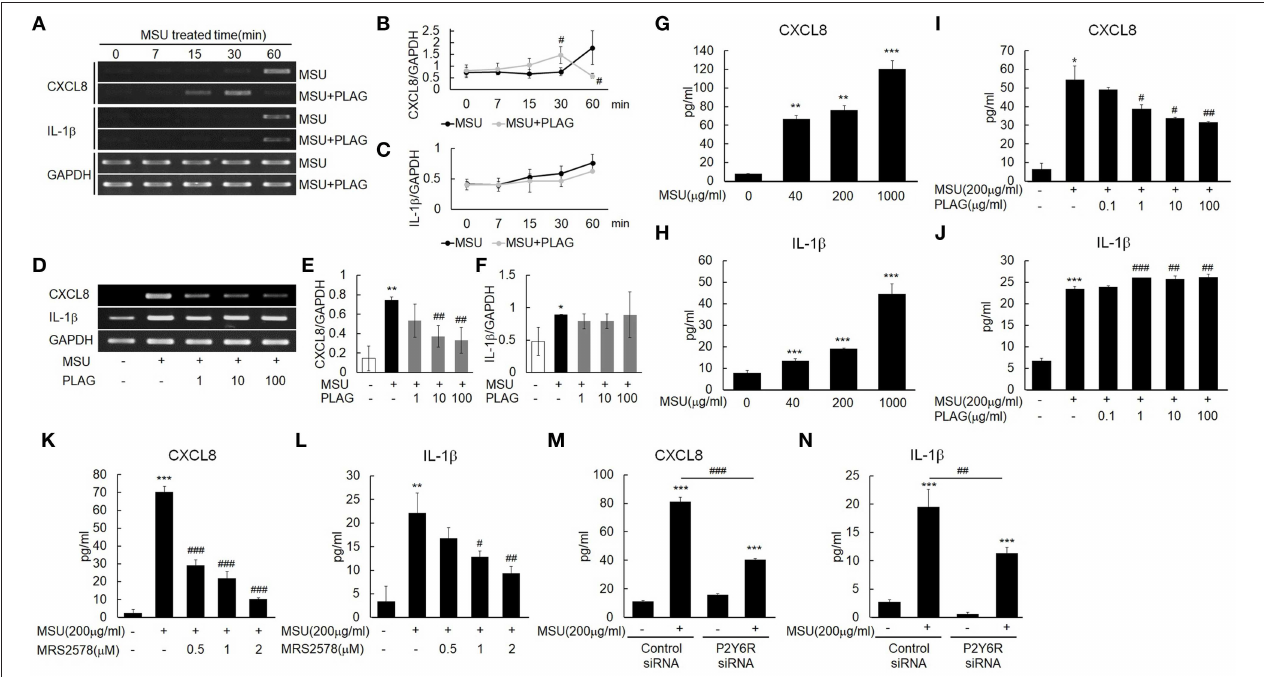
FIGURE 3 | MSU binding to P2Y6 receptor induces CXCL8 and IL-1 β production, and PLAG modulates CXCL8 expression but not IL-1 β expression. (A) Time effect of PLAG on the mRNA expression of MSU-induced CXCL8 and IL-1 β . THP-1 cells were pre-treated with PLAG (100 µ g/ml) for 1h and then were treated with MSU crystals (200 µ g/ml). (B,C) Quantification of (A) . (D) Dose effect of PLAG on the mRNA expression of MSU-induced CXCL8 and IL-1 β .THP-1 cells were pre-treated with different dose of PLAG (1, 10, or 100 µ g/ml) and then were treated with MSU crystals (200 µ g/ml). (E,F) Quantification of (D) . GAPDH was used as a control (G,H) Secreted CXCL8 and IL-1 β were measured using ELISA in the supernatants of THP-1 cells treated with different doses of MSU crystals (50, 200, or 1,000 µ g/ml). (I,J) Secreted CXCL8 and IL-1 β in the supernatant of THP-1 cells pre-treated with different doses of PLAG (0.1, 1, 10, or 100 µ g/ml) for 1h and then treated with MSU crystals (200 µ g/ml) for 24h were measured using ELISA. (K,L) THP-1 cells were pre-treated with MRS2578 (0.5, 1, or 2 µ M) and treated with MSU crystals (200 µ g/ml). Secreted CXCL8 and IL-1 β in the supernatants of THP-1 cells were measured using ELISA. (M,N) THP-1 cells were transfected with control or P2Y6 receptor siRNA (50nM) for 24h. P2Y6-knockdown THP-1 cells were treated with MSU crystals (200 µ g/ml) for 24h, and secreted CXCL8 and IL-1 β in the supernatants of THP-1 cells were measured using ELISA. Data are presented as mean ± SD. * p < 0.05, ** p < 0.01, *** p < 0.001, compared to the control group. # p < 0.05, ## p < 0.01, ### p < 0.001, compared to the MSU-treated